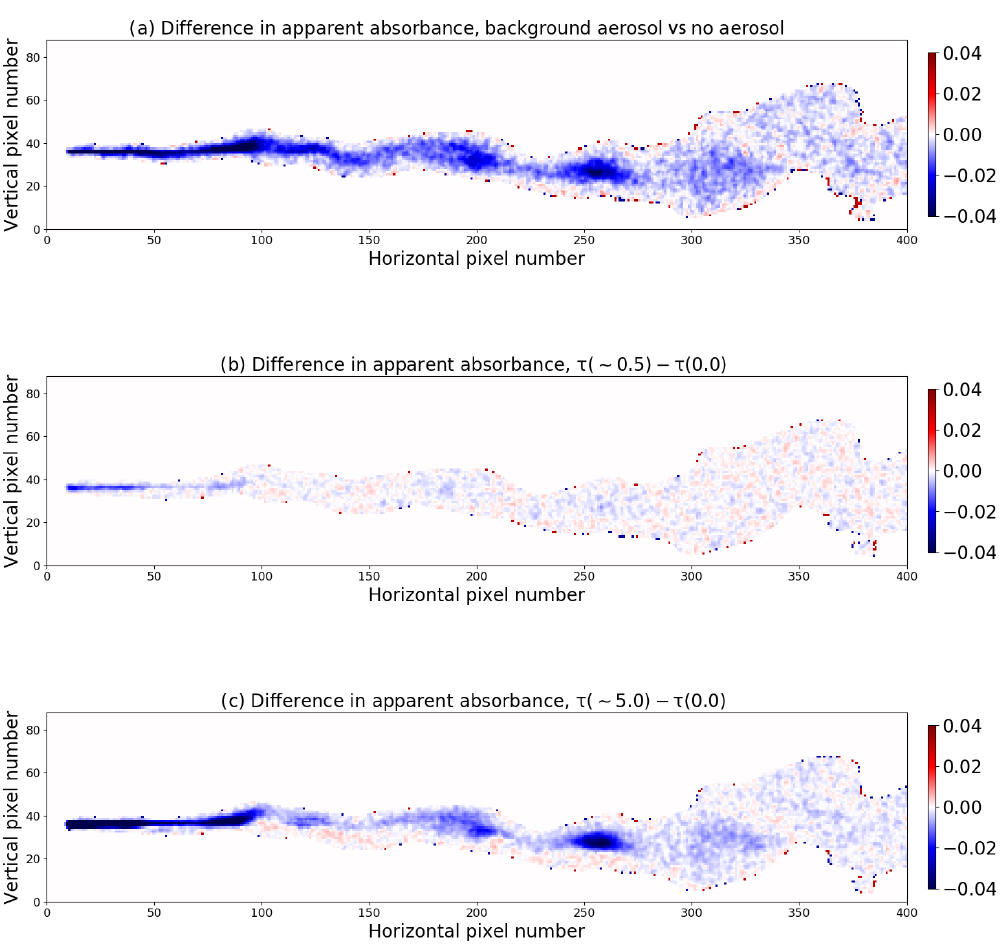
Figure 10. The difference in apparent absorbance from images recorded (a) with and without background aerosols in the atmosphere and (b–c) with and without aerosol in the plume. (b) τ plume ∼ 0 . 5 and (c) τ plume ∼ 5 .